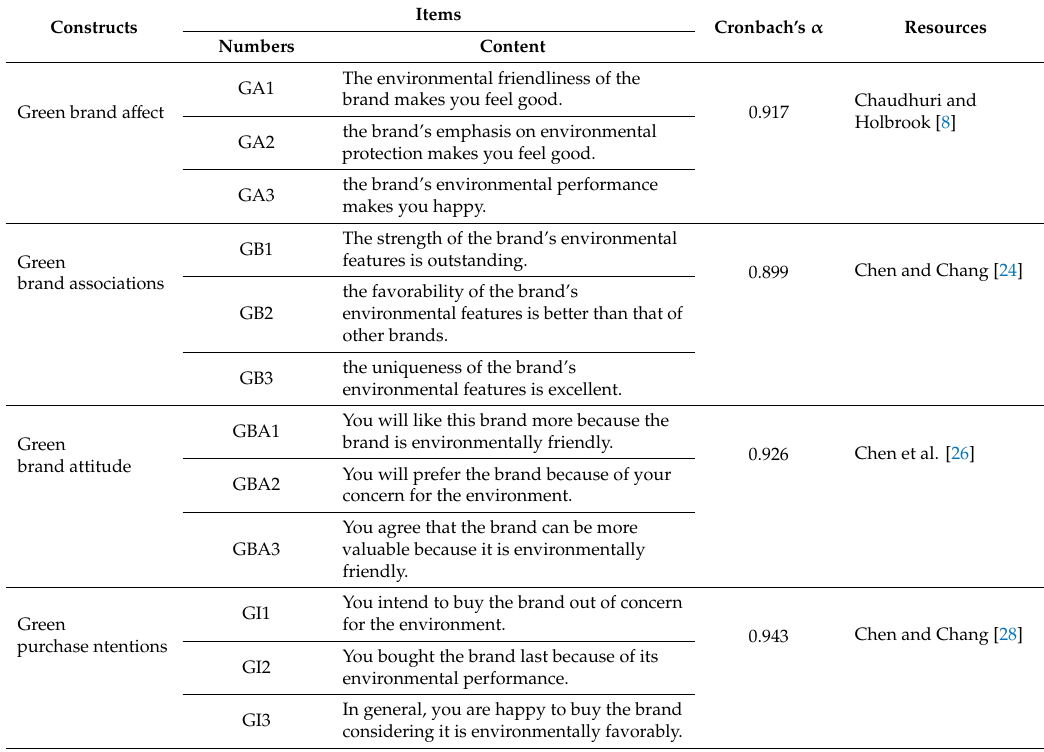
Table A1. The information of the